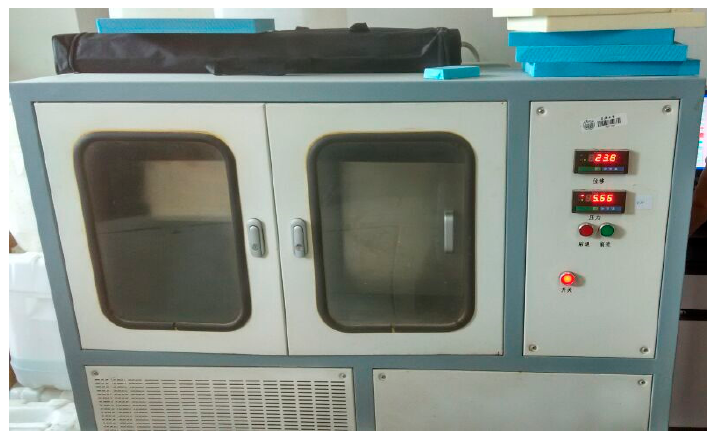
Figure 1. Test instrument.